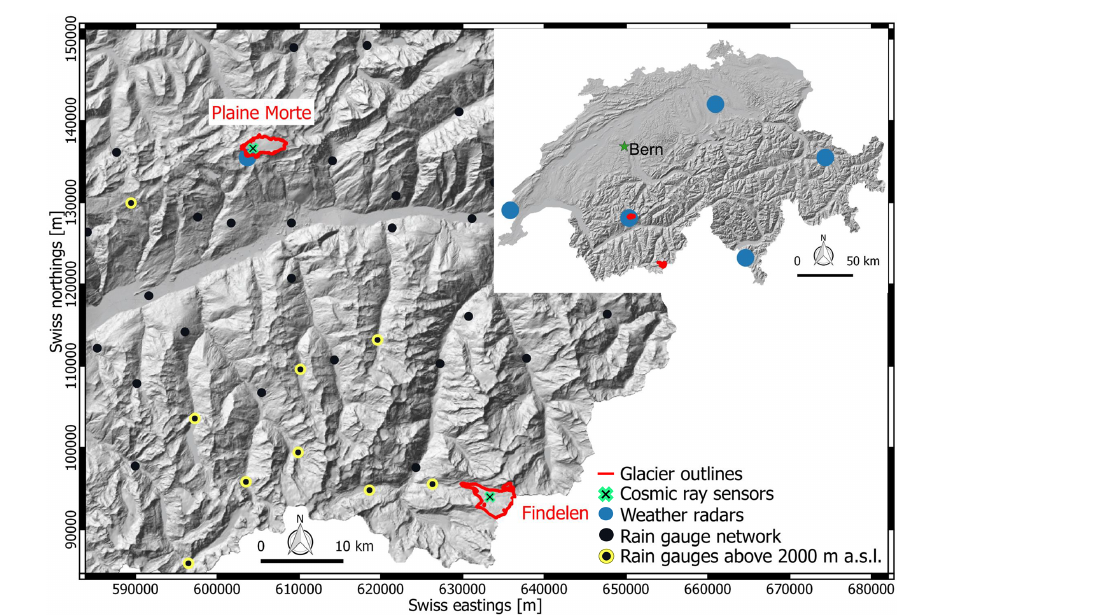
Figure 1. Shown are the location and outlines of Plaine Morte and Findelen glaciers (cf. Fischer et al., 2014), the locations of the CRSs, the weather radar network, and the precipitation gauge network, including stations above 2000ma.s.l. Coordinates refer to the Swiss system (EPSG:21781, maps provided by